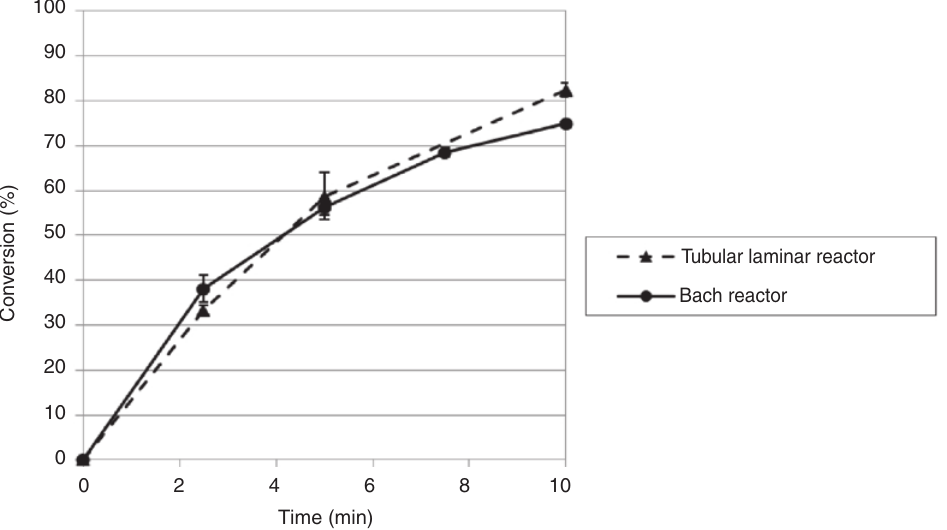
Figure 9: Comparison between performances of tubular laminar and batch reactors at 30 ° C by applying 0.7 M of tris(hydroxymethyl)ami- nomethane (TRIS) as a scavenger and for a 10 min reaction